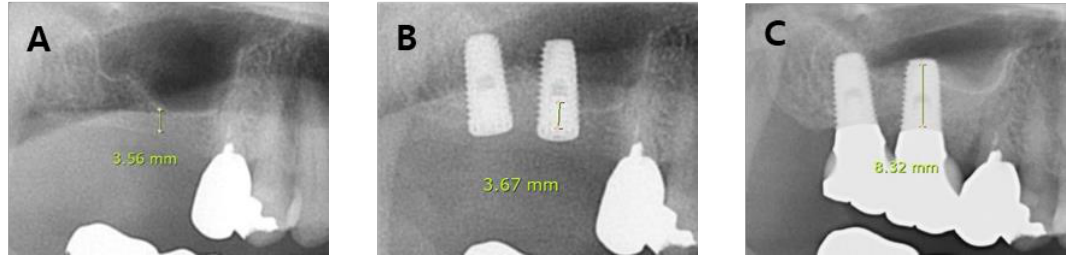
Figure 4. Bone height measured from the crestal bone of group 3. ( A ) Pre op. ( B ) Post op. ( C ) Follow-up.